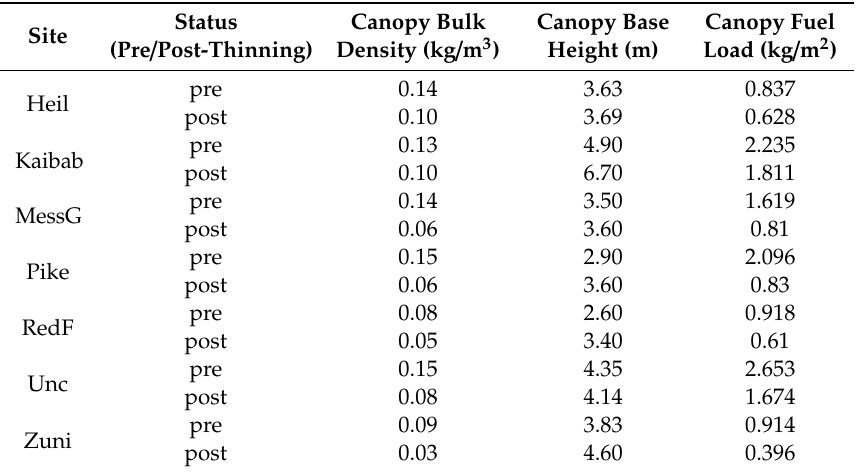
Canopy characteristics of seven forest sites before and after thinning used for fire behavior